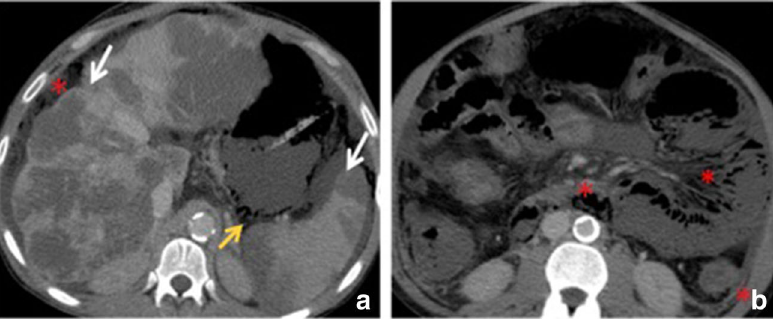
Fig. 12 A 56-year-old male with mesenteric infarction. Axial enhanced CT shows various hypointense rounded regions of infarction in the he- patic parenchyma and wedge shaped in peripheral spleen parenchyma